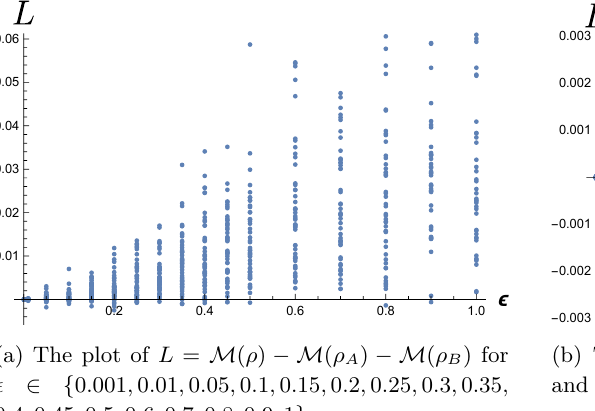
Figure 5 . The long range mana for a collection of pseudo-random “close-to-product” states of two qutrits: H = H . A ⊗ H B 3 ⊗ H 3